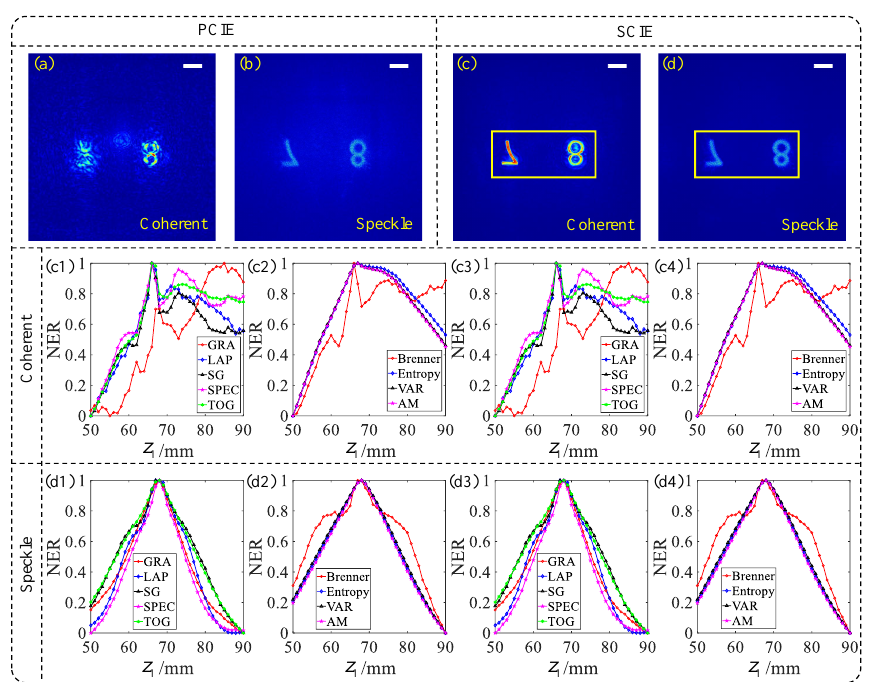
Figure 9. The reconstructed results and normalized CEF curves. ( a – d ) are the reconstructed results; ( c1 – c4 ) are the CEF curves for diffraction patterns; ( d1 – d4 ) are the CEF curves for speckle patterns. NER: normalized evaluation result. The white bar corresponds to 620 µ